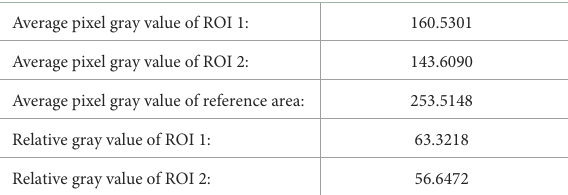
TABLE 3 Relevant calculation data for quantitative analysis of echo intensity of white matter in plane three brain. Average pixel gray value of ROI